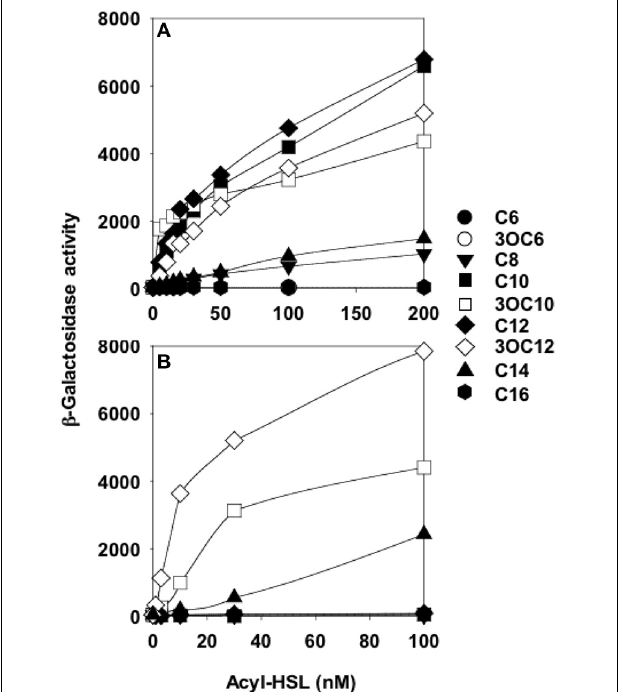
FIGURE 2 | QscR, unlike LasR, responds to multiple AHLs. Shown are lacZ reporter expression levels for (A) E. coli containing a qscR expression vector and the PA1897– lacZ reporter and (B) E. coli containing a lasR expression vector and the lasI – lacZ reporter. The acyl chains of each AHL are indicated on the right from Lee et al.